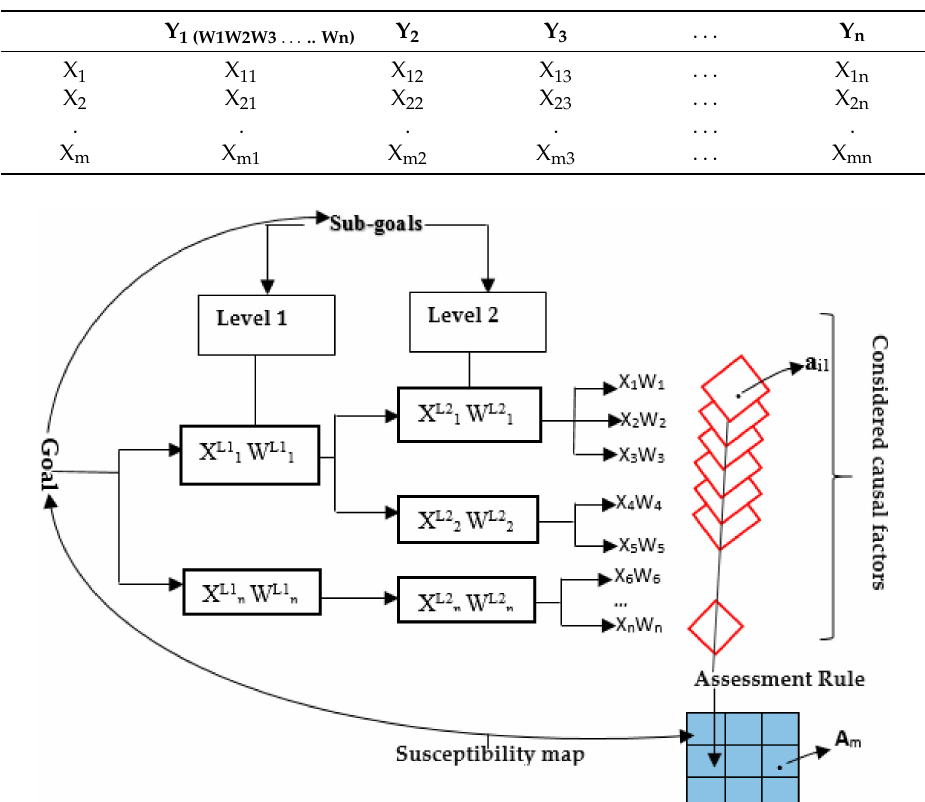
Table 3. Multi-criteria decision matrix in Geographical Information System (GIS)-Integrated Land and Water Information System (ILWIS)-Spatial Multi-Criteria Evaluation (SMCE).